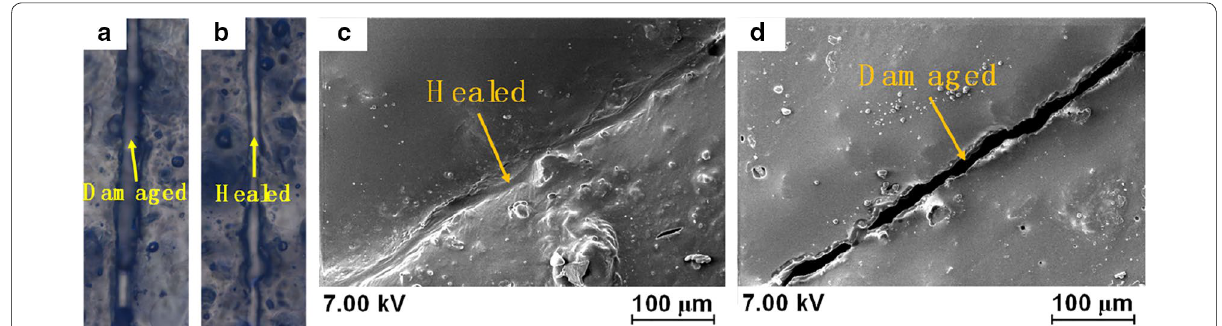
Fig. 4 Optical micrographs of the healed region on self-healing coatings after a 0 and b 4 days; SEM micrographs of the healed region on self-healing coating; c self-healing coatings; d control